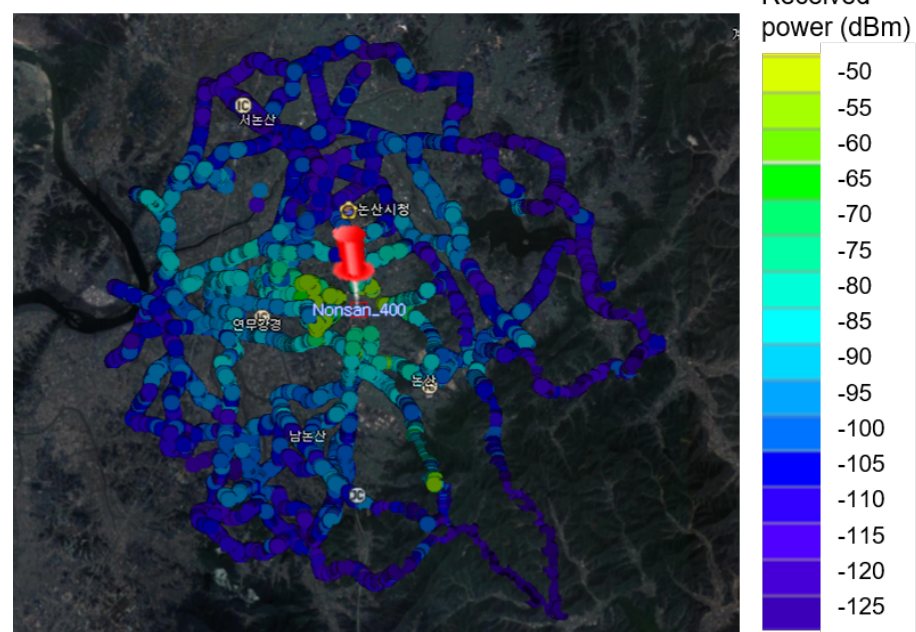
Figure 8. Measurement path and received power